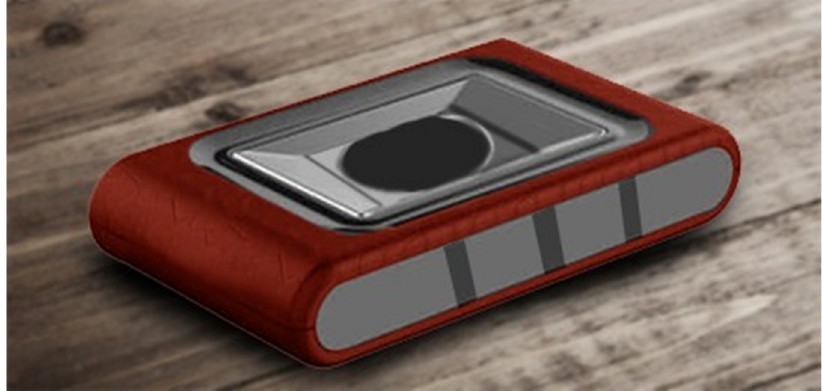
Figure 2. FKP acquisition device .